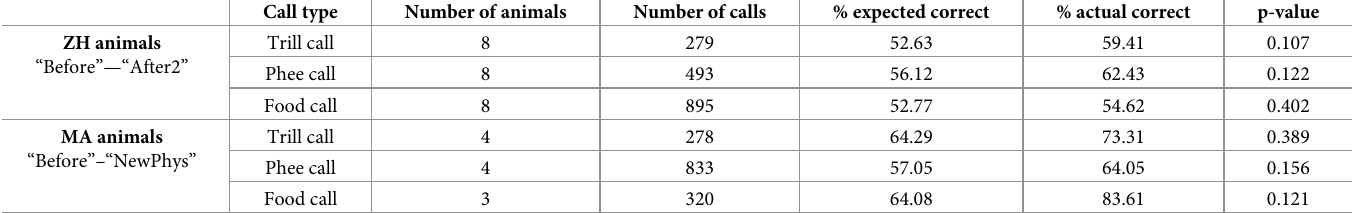
Table 2. Long-term environmental accommodation. ZH animals that were recorded again 5–6 weeks after translocation (“After2”), as well as four additional MA ani- mals that were recorded 4–7 weeks after translocation (“NewPhys”), did not differ in their call structure compared to before the translocation. The new environment thus did not lead to persistent, long-term environmental accommodation. % of expected calls indicate the amount of correct classification if classification were random, % actual correct the amount of correct classification the pDFA achieved with the